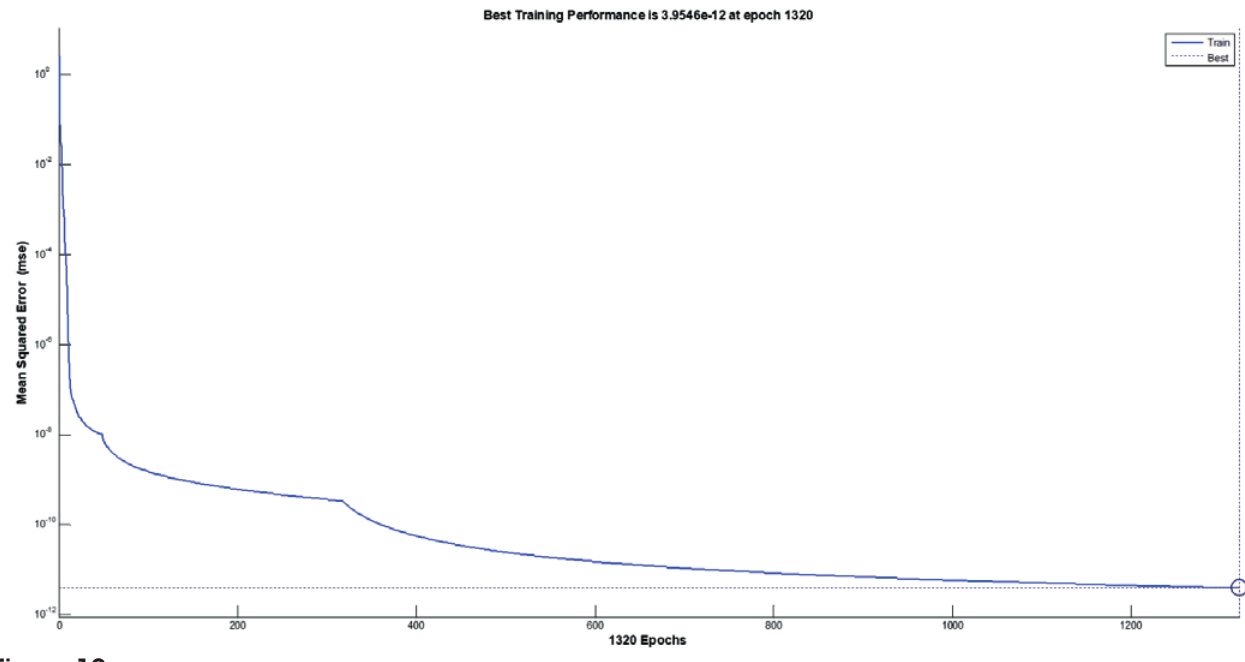
Evolution of Artificial Neural Network training - ANN 10x40x80x1